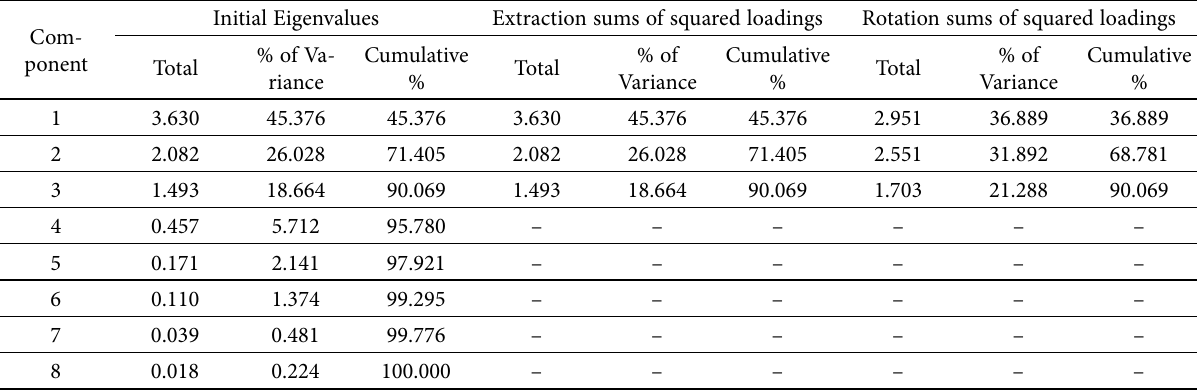
Table 3. Factor loadings in factor analysis with varimax method